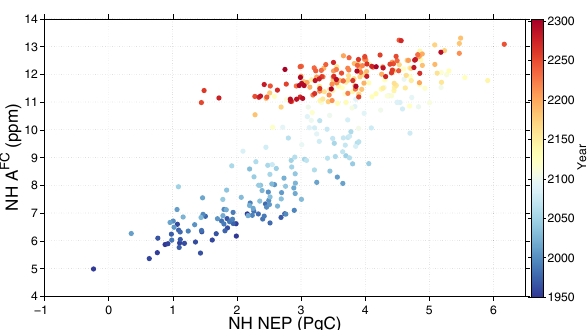
Figure 9. NH mean CO 2 annual cycle amplitude (ppm) as a func- tion of annual mean NH NEP (PgC). NEP < 0 indicates net carbon uptake by land, and circles are shaded by simulation year. The re- lationship between amplitude and net land carbon exchange shows evidence of hysteresis, with different slopes before and after